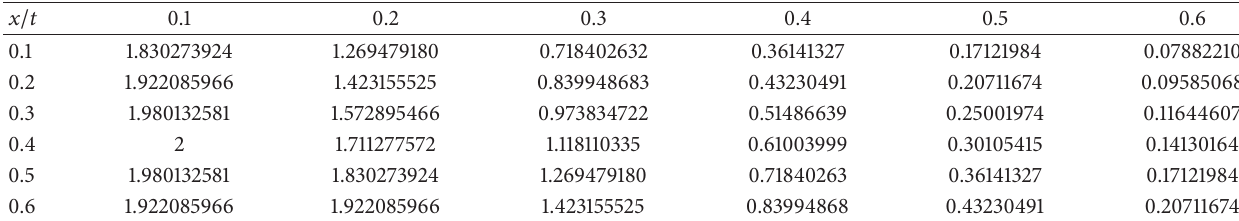
Table 1: The exact solution of Example 10 for initial condition at 0.1 ≤ 𝑥 , 𝑡 ≤ 0.6 .